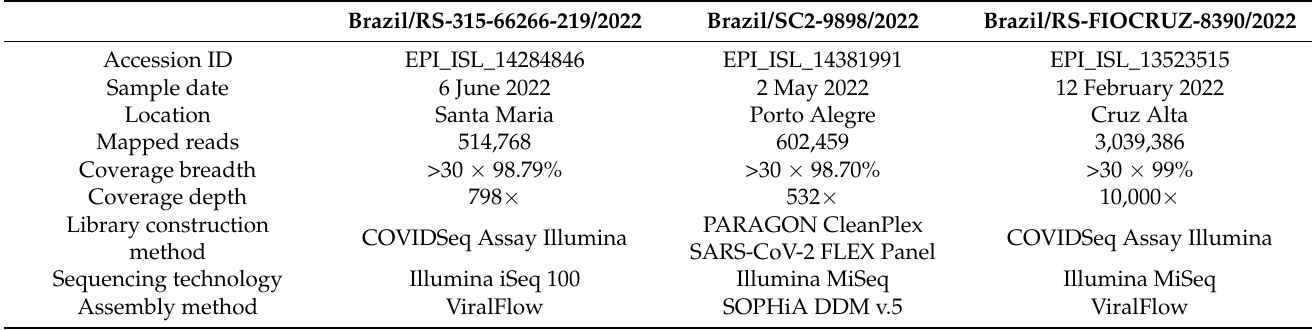
Table A1. Clinical data of the samples and characteristics of the genomes sequenced in this study.